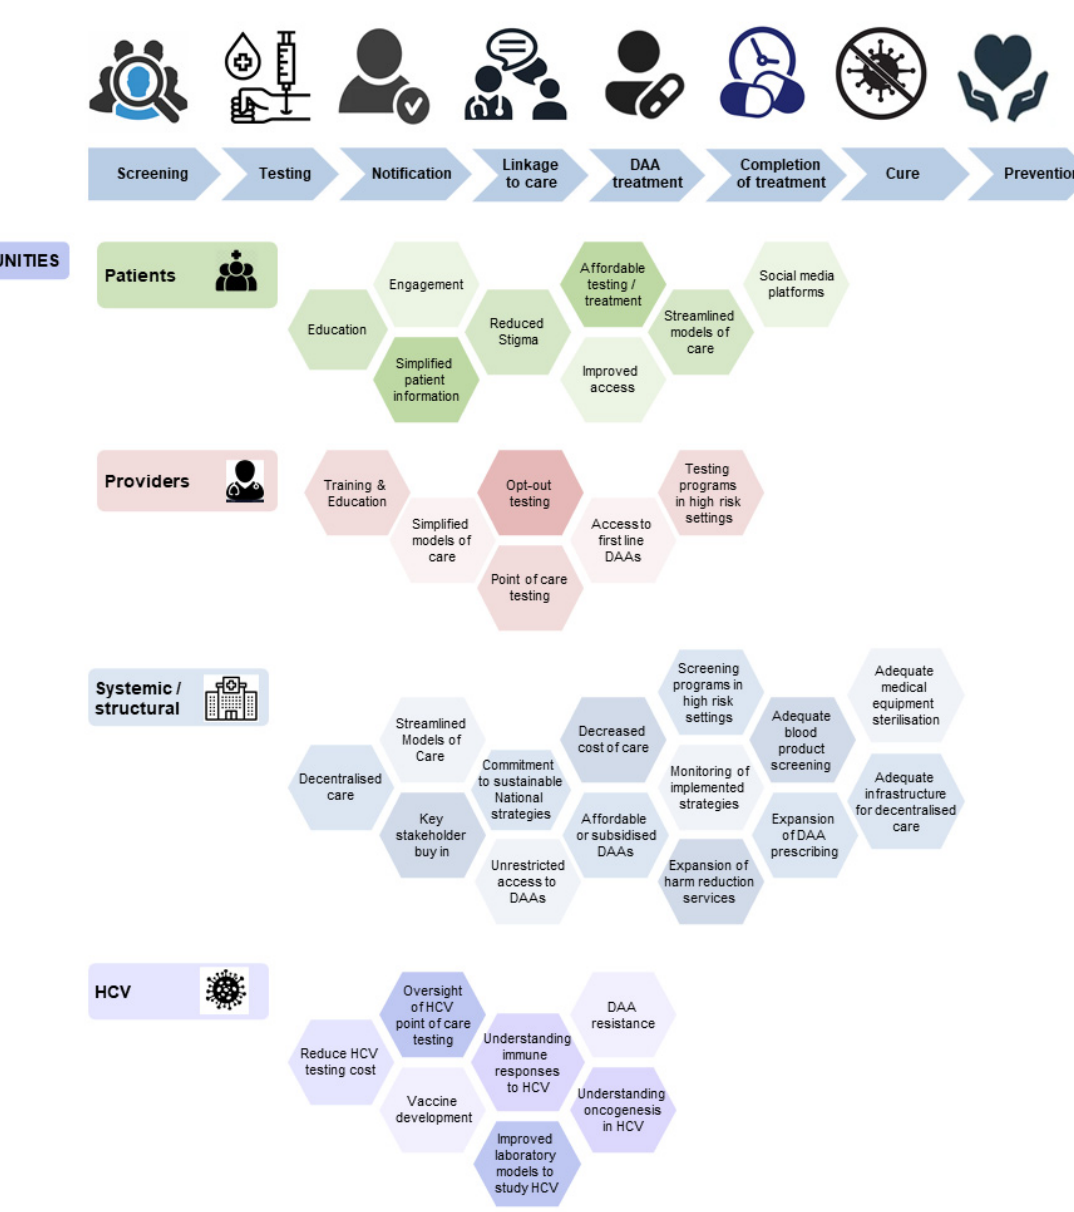
Figure 2. Opportunities in hepatitis C care. DAA = direct acting antivirals; HCV = hepatitis C virus.